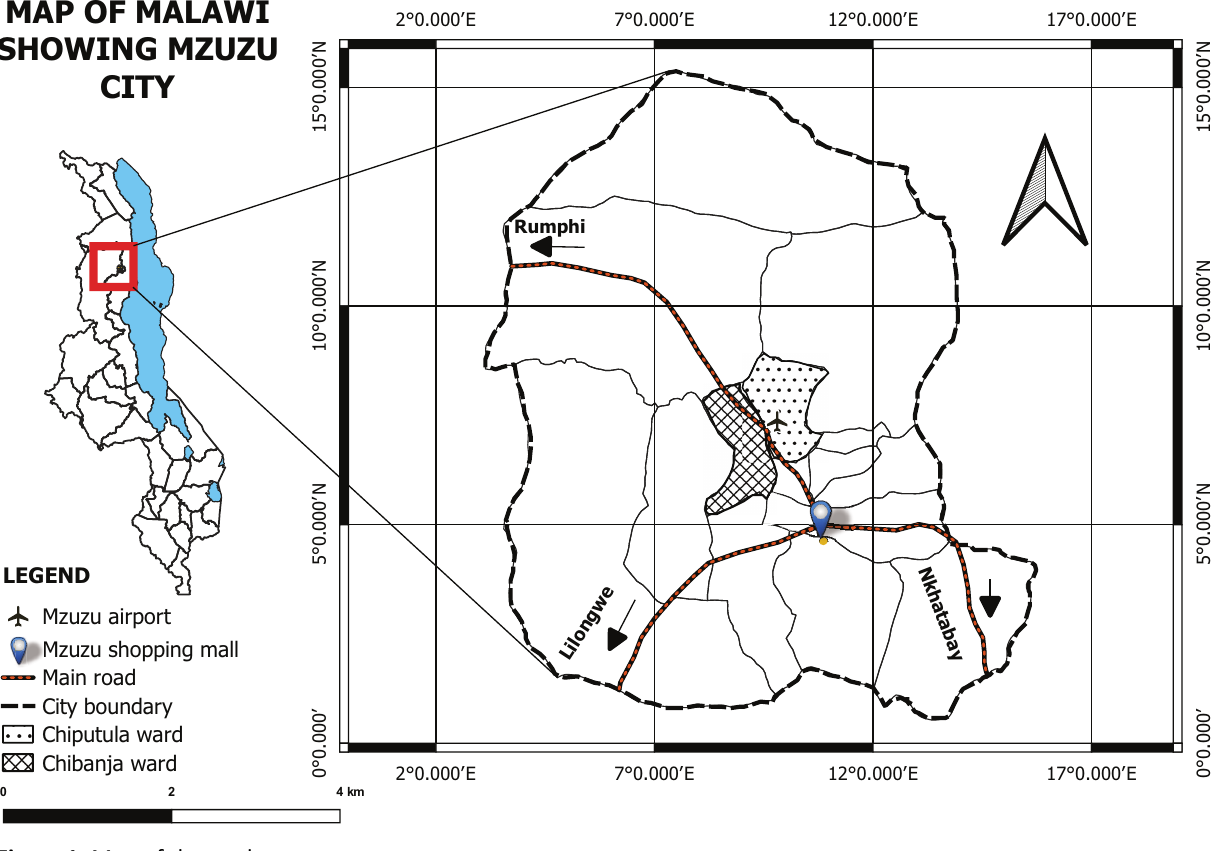
Figure 1. Map of the study